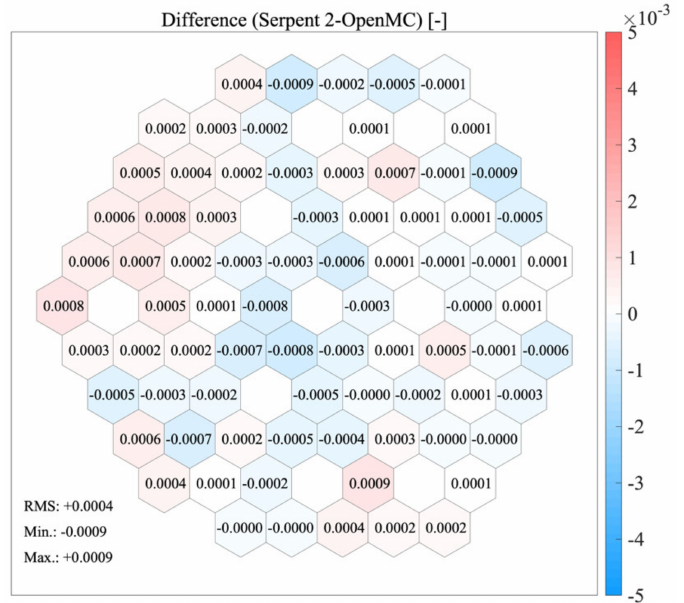
Figure 7. Difference in assembly power at operation loading with control-rod positions of “2 × RE + 3 × SH + 3 × SA Before”.